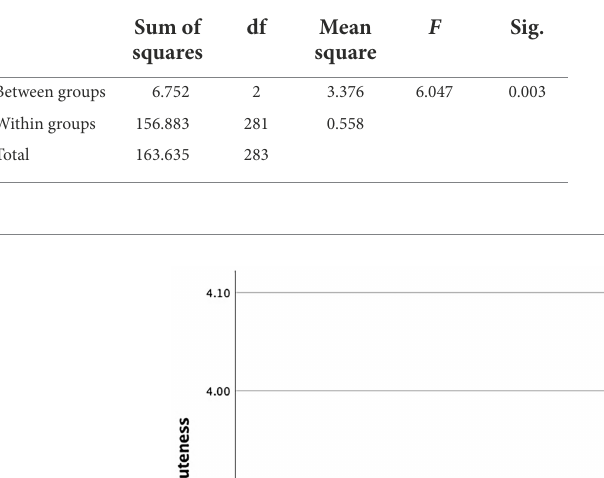
TABLE 3 ANOVA results (perceived